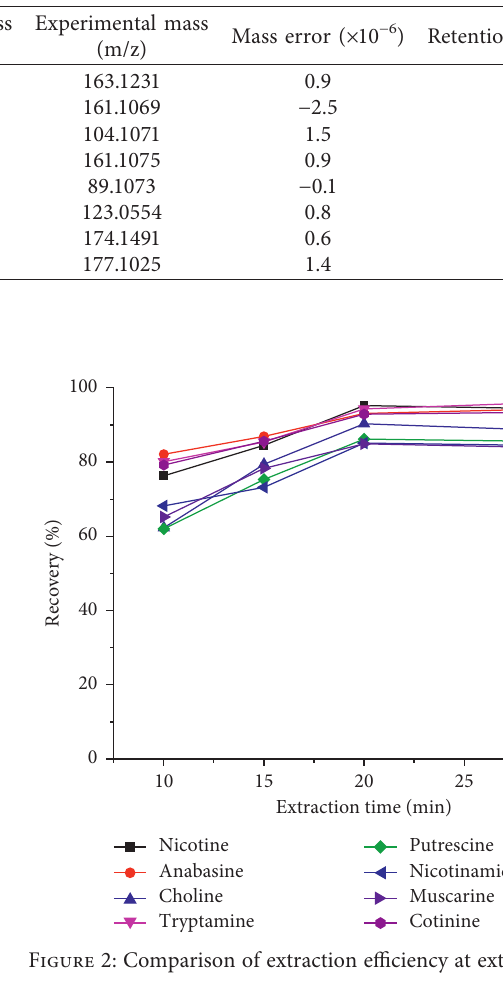
Table 1: Mass parameters for the 8 endogenous alkaloids.